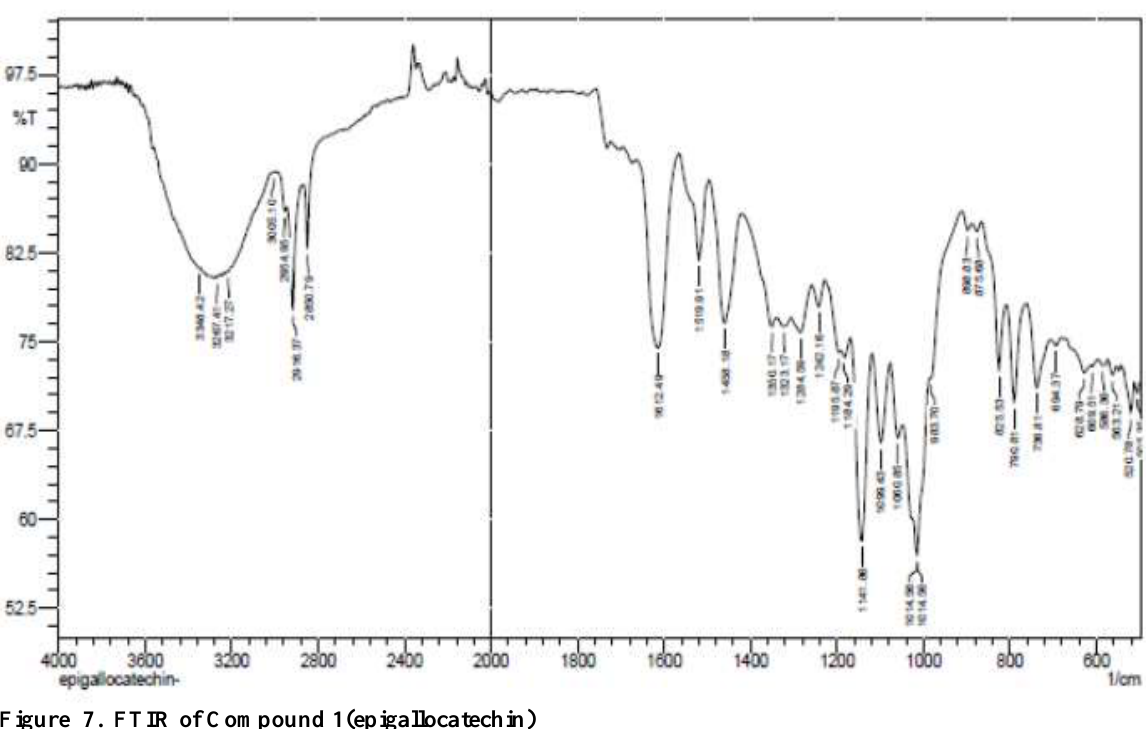
Figure 7. FTIR of Compound 1(epigallocatechin) Table 5. FTIR Interpretation of Compounds I Group frequency wave number in cm –